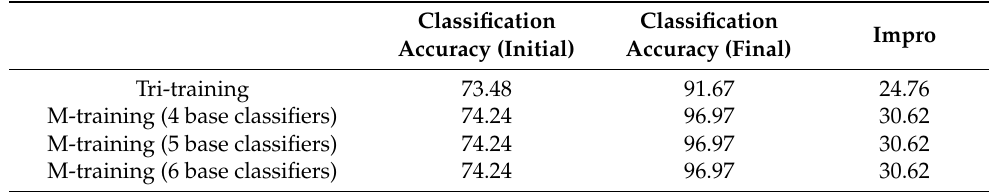
Table 5. Performance of tri-training and M-training with different number of base classifiers (%).